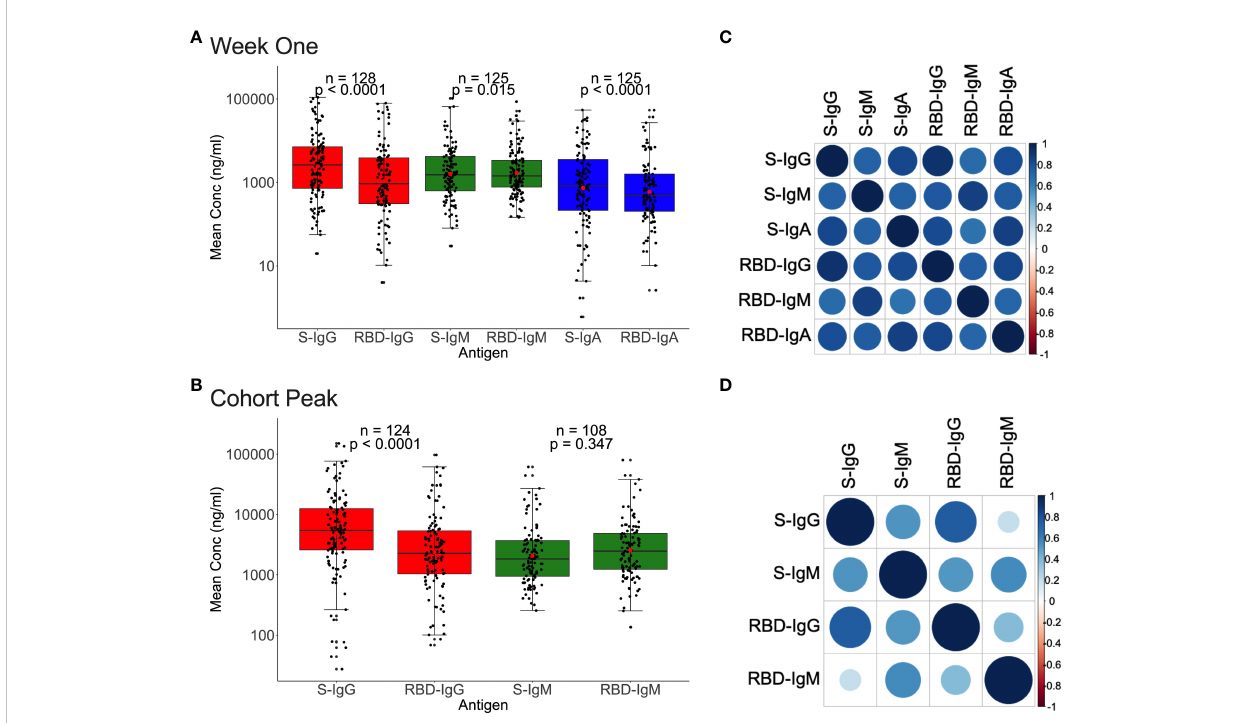
FIGURE 5 Relationships between Spike and RBD antibody concentrations. Figure 5 demonstrates the association between whole Spike- and RBD-directed antibody concentrations during the fi rst week (A) and the cohort peak (B) of the primary antibody response. Box plots compare Spike and RBD antibody concentration medians using a paired Wilcoxon test. Correlation plots show the pairwise Spearman ’ s rank correlations between entire Spike and RBD ODs during the fi rst week of the primary antibody response (C) and the cohort peak (D) . Positive correlations are symbolized by blue, while negative correlations are indicated by red. Darker and larger circles represent stronger correlations, lighter and smaller circles represent weaker correlations, and blank squares represent insigni fi cant correlations; p-values lee than or equal to 0.05 were deemed signi fi cant. See also Supplementary Figure